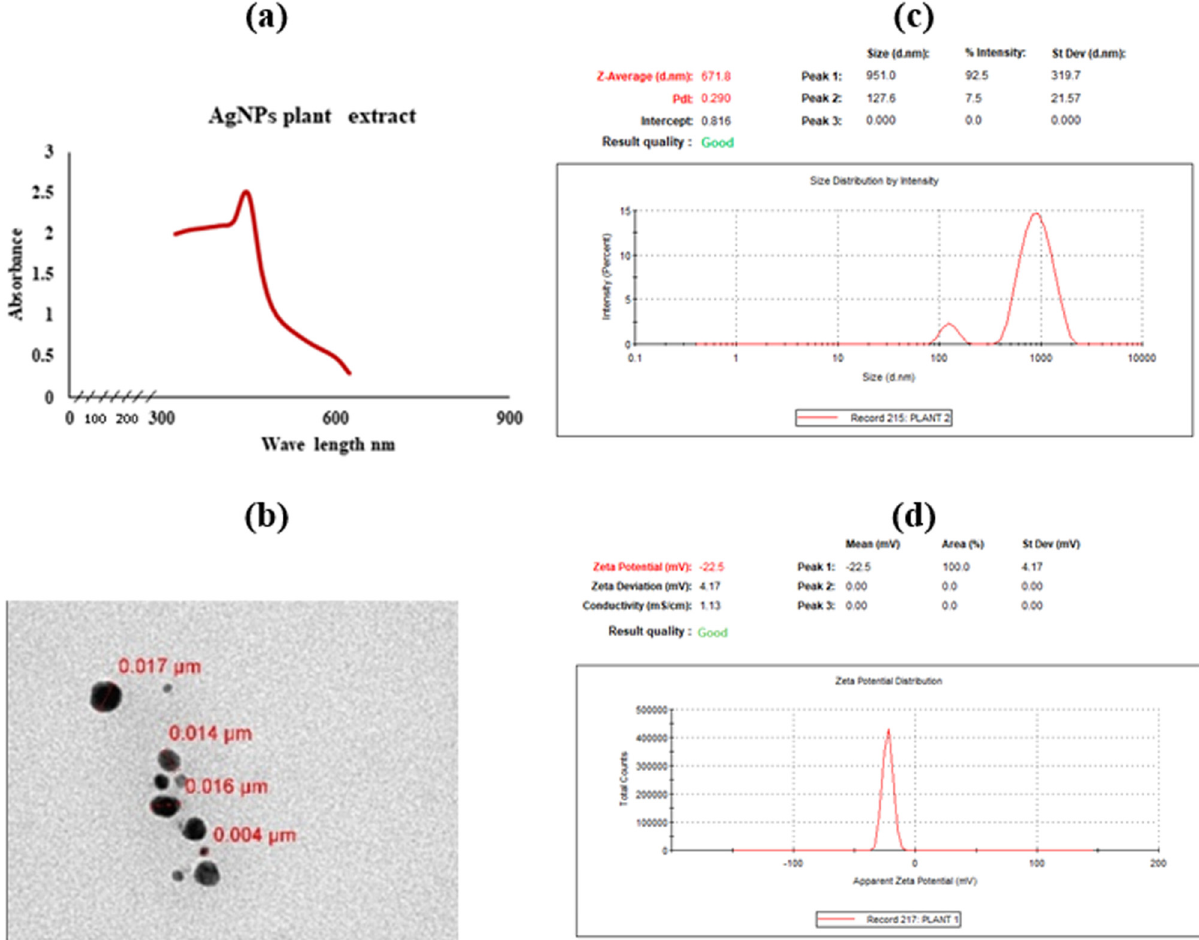
Figure 2: Characterization of biological synthesized C. gileadensis AgNPs: ( a ) UV - Vis spectra showing absorbance peak, ( b ) TEM micro - graph, ( c ) zeta sizer – DLS, ( d ) zeta potential distribution –